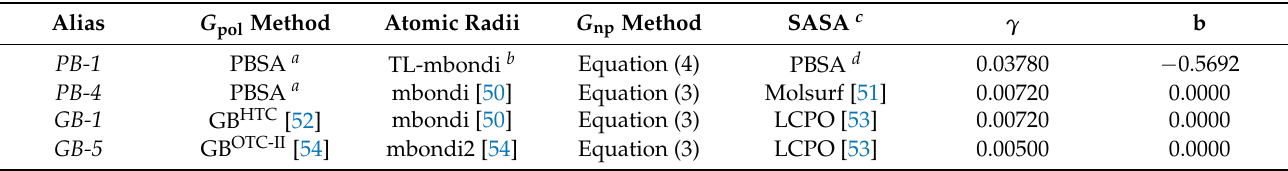
Table 4. Summary of the parameter sets employed in free energy calculations, indicating the method used for calculation of the polar ( G pol ) and the non-polar solvation energy ( G np )